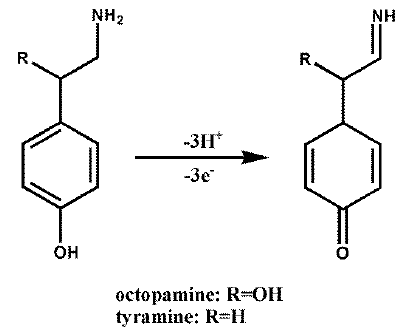
Figure 5. Possible reaction for electrochemical oxidation of OA and TA at the surface of ERGO/GCE.